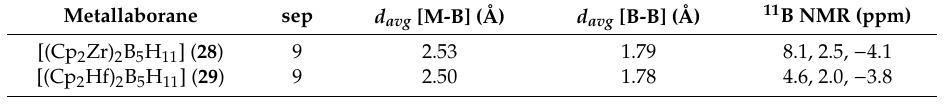
Figure 11. Generation of the core structure of compounds 28 and 29 from cluster fusion. Table 6. Skeletal electron pair count (sep), selected structural parameters, and 11 B chemical shifts of 28 and 2 9 of type IV .